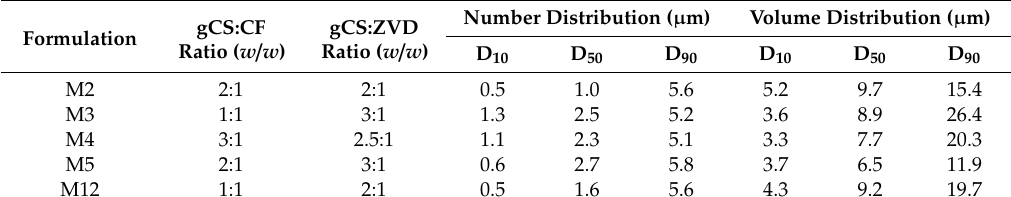
Table 3. Number and volume size distribution characteristics of the selected gCS / CF microparticles with zidovudine (ZVD).